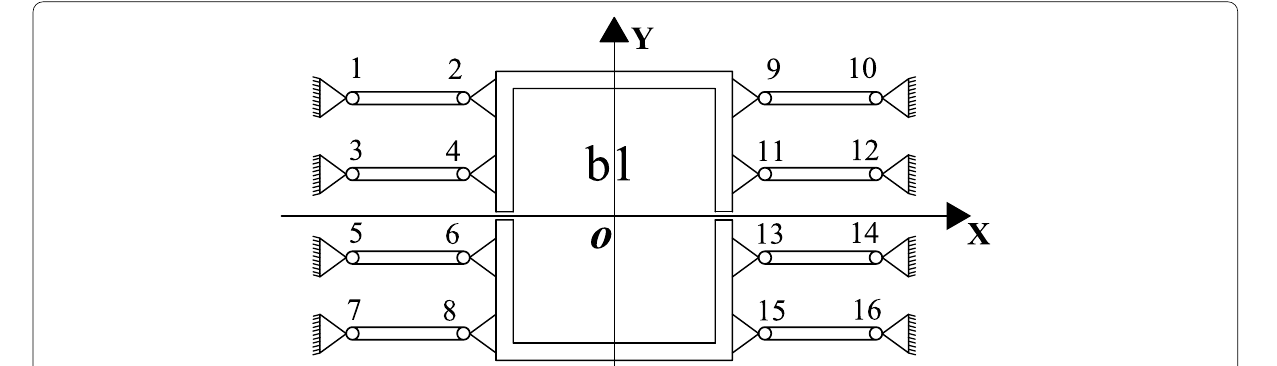
Fig. 3 Guiding principle diagram of micro-drive mechanism